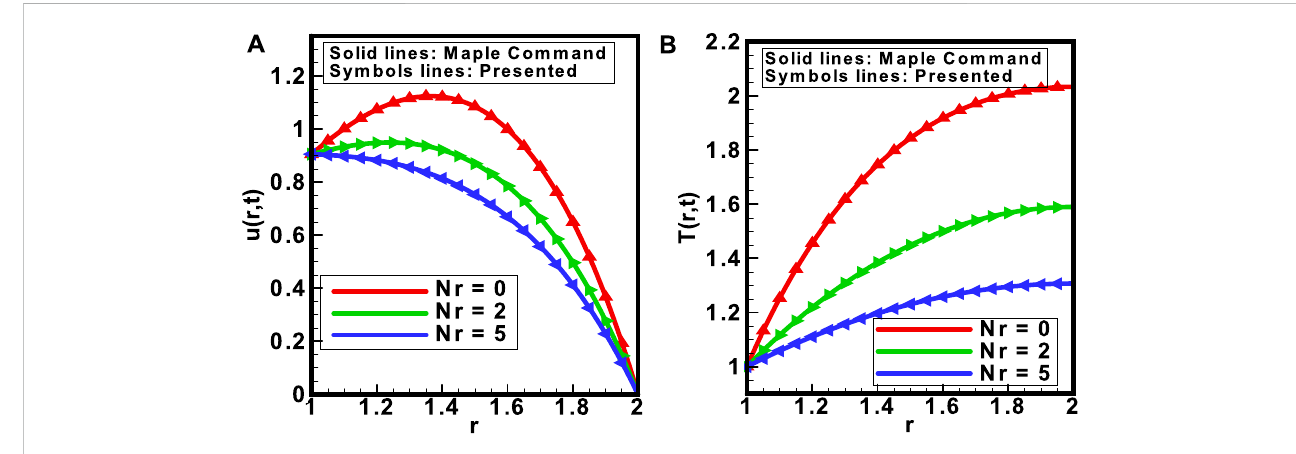
FIGURE 13 ComparisonbetweentheMAPLEbuilt-incommandresultsandresultsobtainedfromthemodelfor (A) velocityand (B) temperaturepro fi lesinrespectto the variation in Nr .